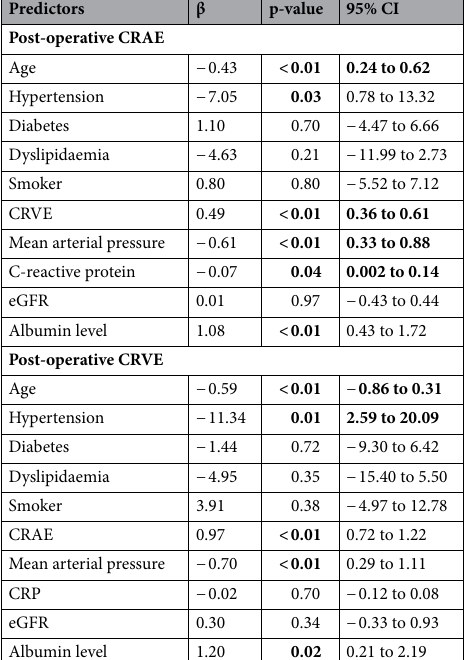
Table 4. Predictors of vessel calibre (CRAE and CRVE) using univariate analysis. Significant values are in